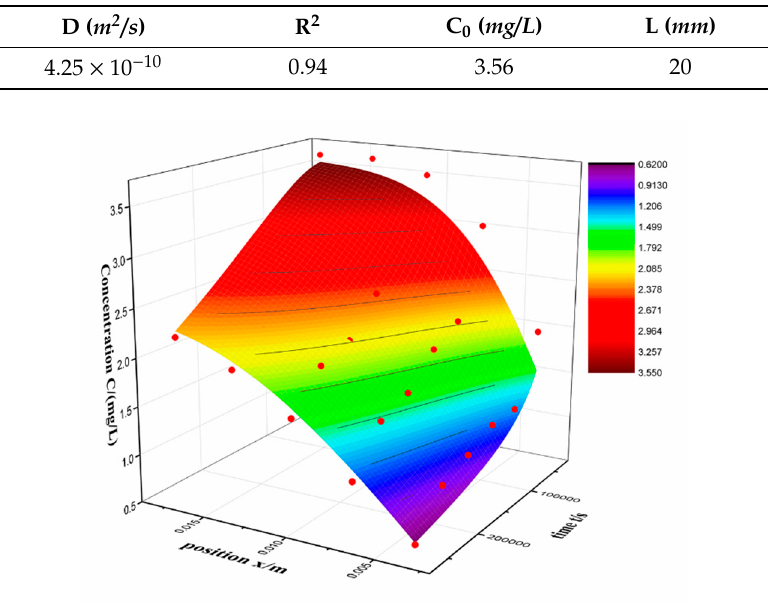
Table 5. Fitting result of outward diffusion coefficient.